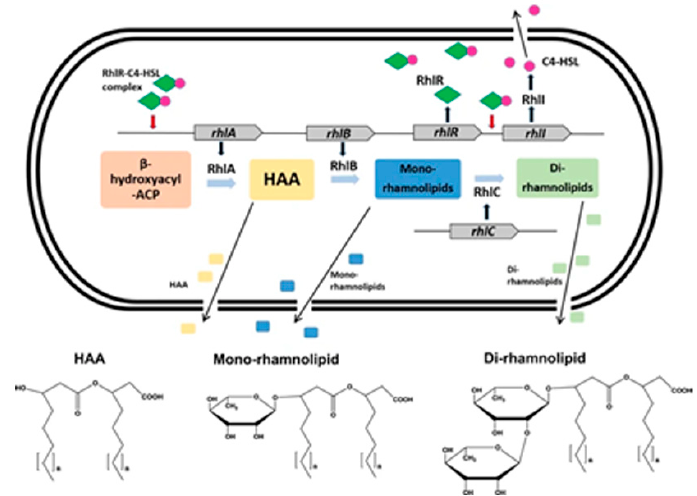
Figure 3. Rhamnolipid pathway in P. aeruginosa and its regulation by Rhl system. RhlR (green diamonds) binds with C 4 -HSL (magenta circles) produced by RhlI to form a RhlR–C 4 -HSL complex. RhlR–C 4 -HSL complex interacts with the rhlA promoter to initiate transcription of the rhlAB genes to produce rhamnolipids. HAA is 3-(hydroxyalkanoyloxy) alkanoic acid, which is converted into mono, and later di-rhamnolipids. Other studies have indicated LasR, and not RhlR, activate rhlI transcription; and that sometimes the precursor of RhlA is not 3-hydroxy-acyl-ACP (may be activated in CoA). Figure reproduced from Wood TL et al., 2018